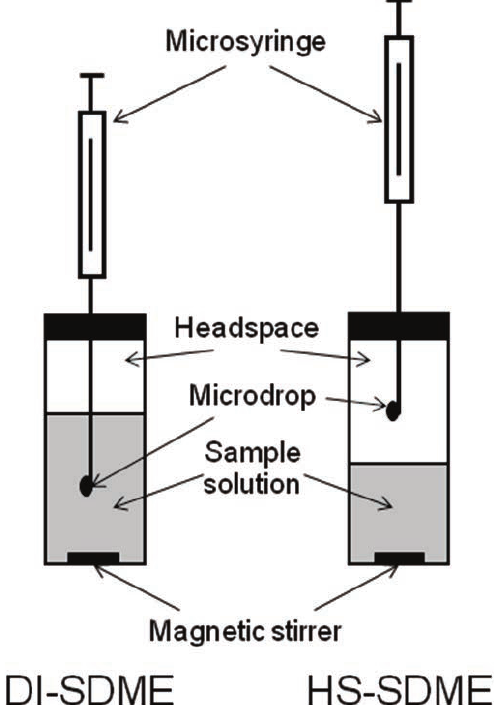
Figure 4. Schematic diagram of